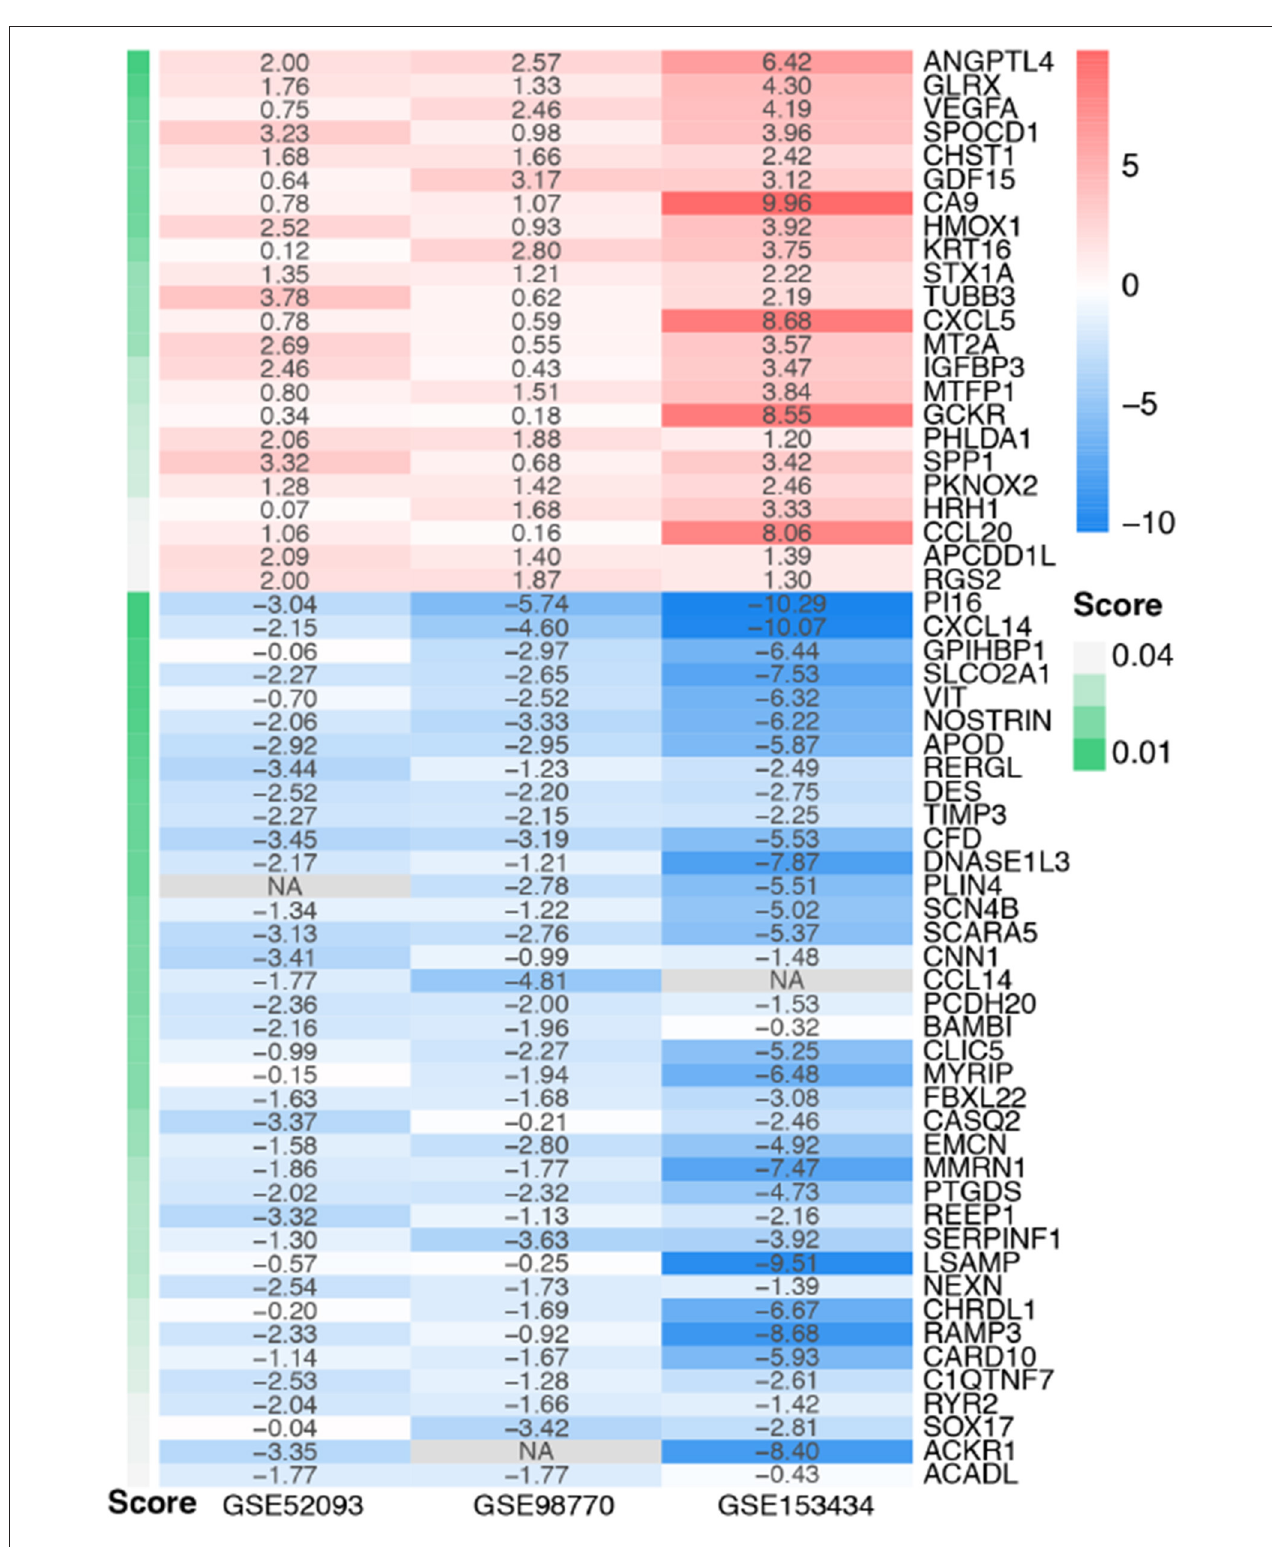
FIGURE 3 | Heatmap of the integrated DEGs. Red represents upregulated genes, blue represents downregulated genes, gray represents genes that were not detected in some datasets, and gradation of green represents the score obtained in the RRA analysis.